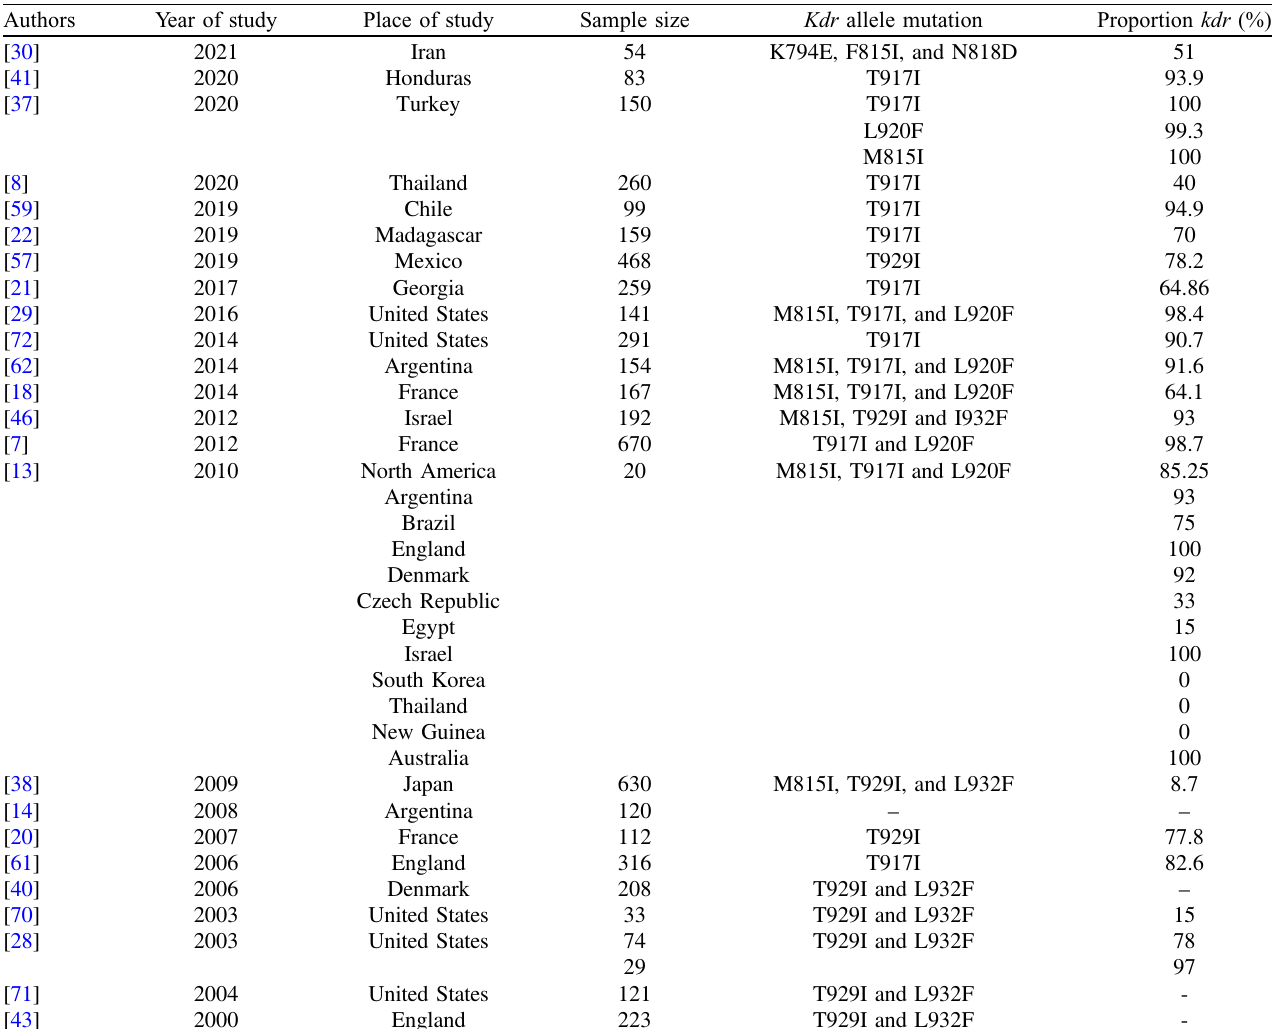
Table 1. General characteristics of the included studied in the data analysis